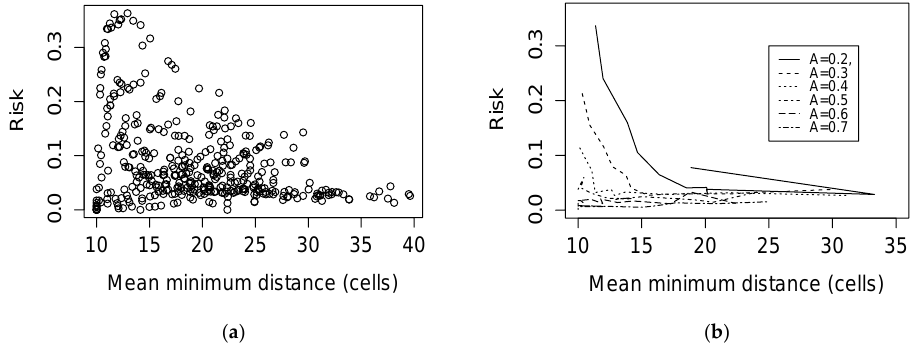
Figure 4. Predicted Lyme disease risk as a function of mean minimum distance between patch edges, ( a ) across all simulated landscapes and ( b ) stratified by habitat occupancy A . Each curve connects landscape scores evaluated at sequential values of percolation probability p (0.05–0.5)